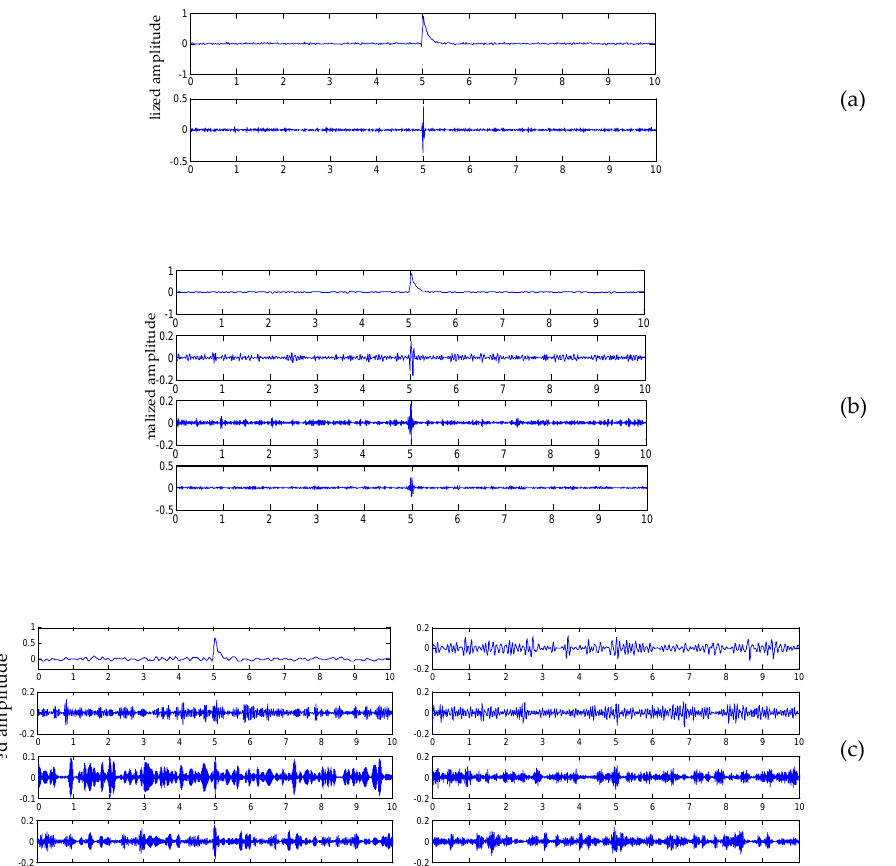
Figure 3. Adaptive wavelet packet decomposition results of different noisy signals. ( a ) Noisy signal with 0 dB. ( b ) Noisy signal with − 2.5 dB. ( c ) Noisy signal with − 13 dB.